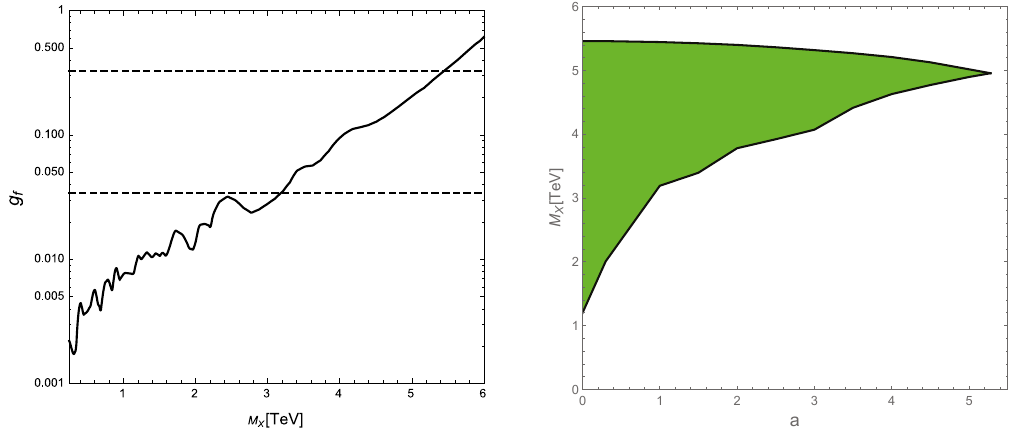
Figure 3 . Left panel : the upper bound on g f (solid line) as a function of M X from the ATLAS results [33]. Along with the LHC bound, we also show the perturbativity condition on g f . The two horizontal lines depict g f | and g f | for a = 1 . Combining the LHC bound and the min max perturbativity condition, we find the allowed region, 3 . 19 ≤ M X [TeV] ≤ 5 . 45 for a = 1 . Right panel : the allowed region of M X (green shaded) for various values of a after combining the LHC bound and the perturbativity